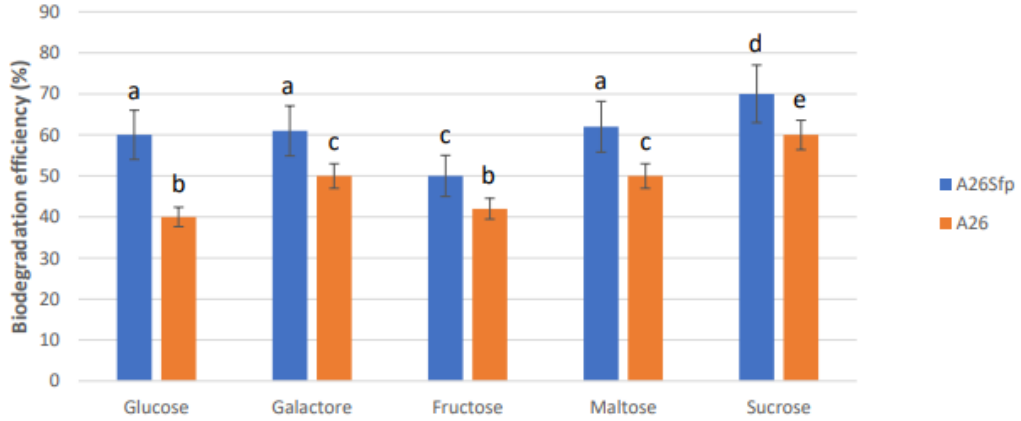
Figure 3. Effect of carbon sources on biodegradation of naphthalene by Paenibacillus polymyxa A26 and P. polymyxa A26Sfp. Different letters indicate statistically significant differences; see Material and Methods.